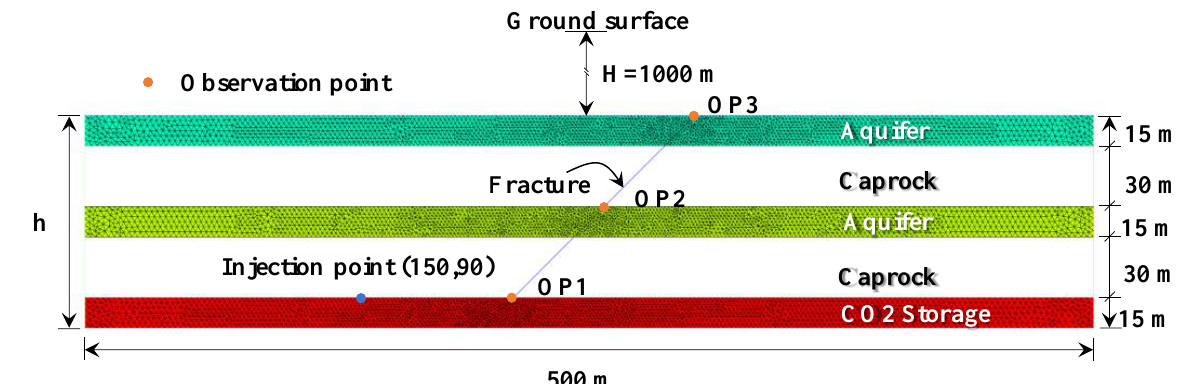
Figure 3. Finite element geometry of the faulted reservoir.